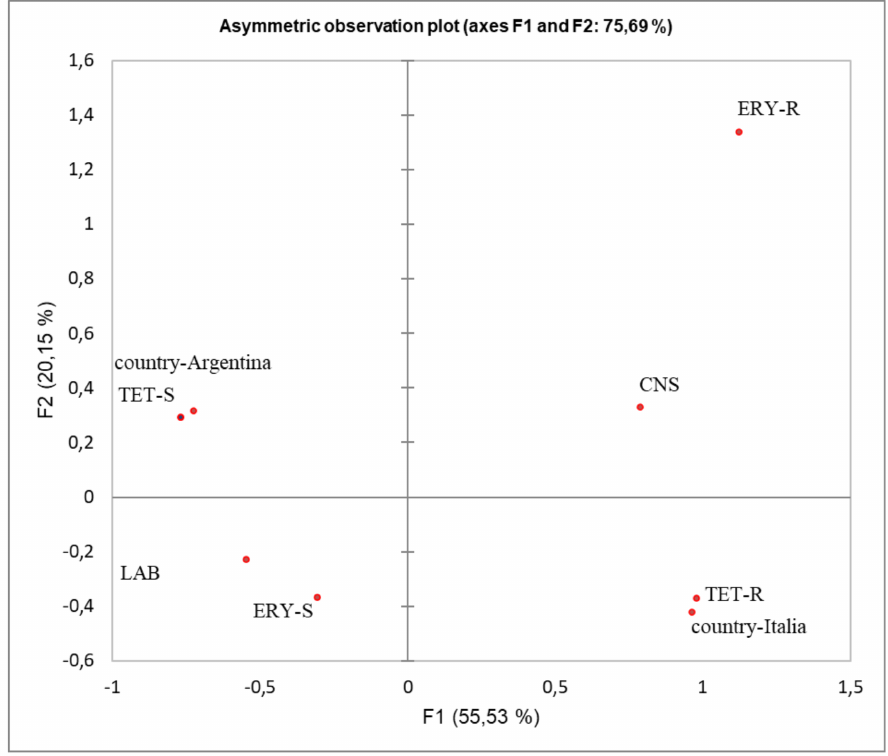
Figure 2. Multivariate correspondence analysis (MCA) summarizing the associations between antibiotic resistance phenotypes (R and S) regarding the LAB and CNS groups isolated from Italian and Argentinean fermented sausages. The contribution to the Chi-squared test is indicated for each